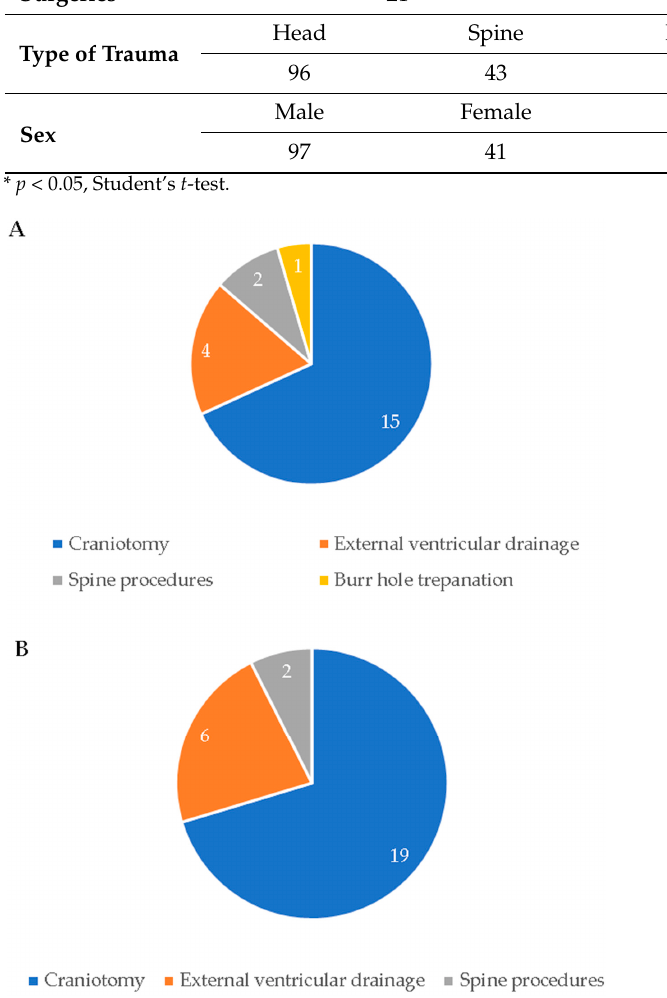
Figure 3. Emergency surgeries of neurosurgical trauma patients transferred to University Hospital Center Osijek in pre-pandemic ( A ) and pandemic ( B ) period.